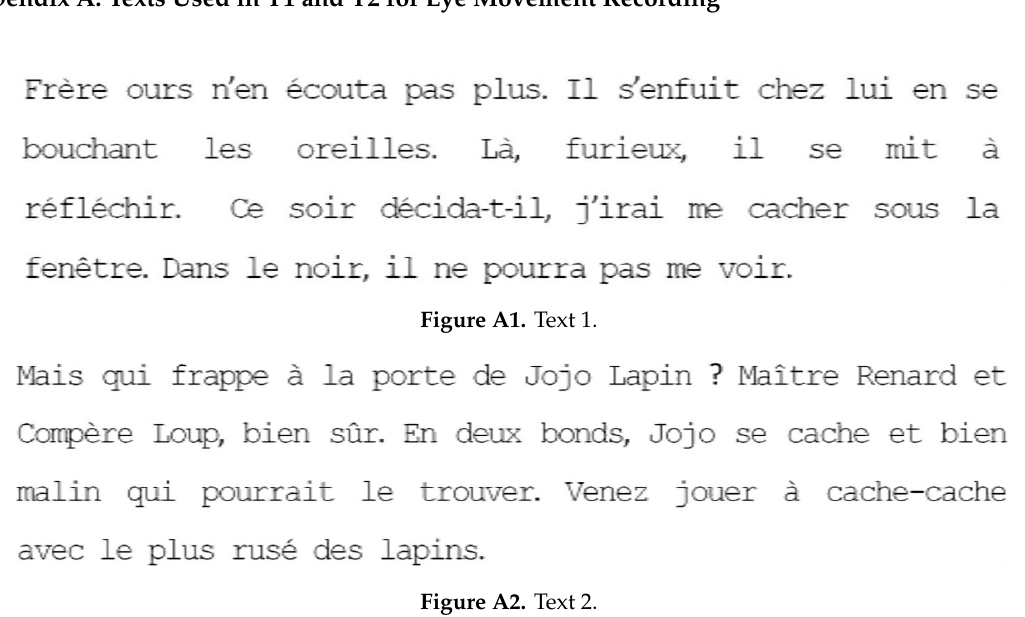
Figure A2. Text 2.